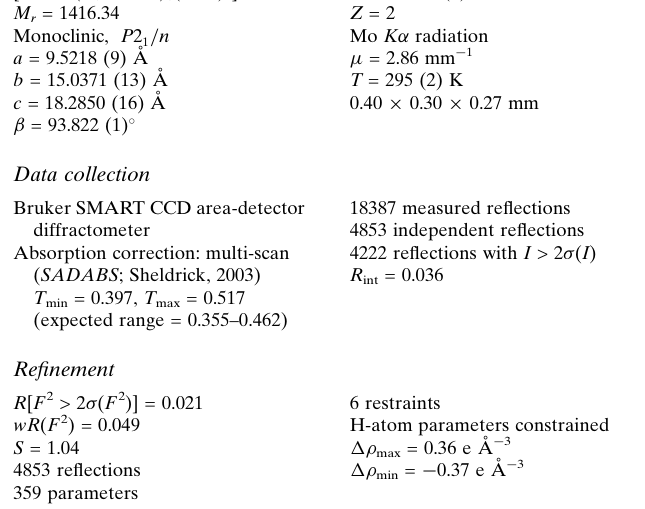
one-dimensional chain structure. The four-coordinate Cu II ion O geometry and is (site symmetry 1) adopts a trans -CuN 2 2 bridged by two carboxylate groups from two isonicotinate ligands. The Eu III ion adopts a distorted square-antiprismatic geometry, being coordinated by four O atoms from bridging carboxylate groups of four isonicotinate ligands, two O atoms from chelating carboxylate groups of one isonicotinate ligand and two O atoms from coordinated water molecules; adjacent